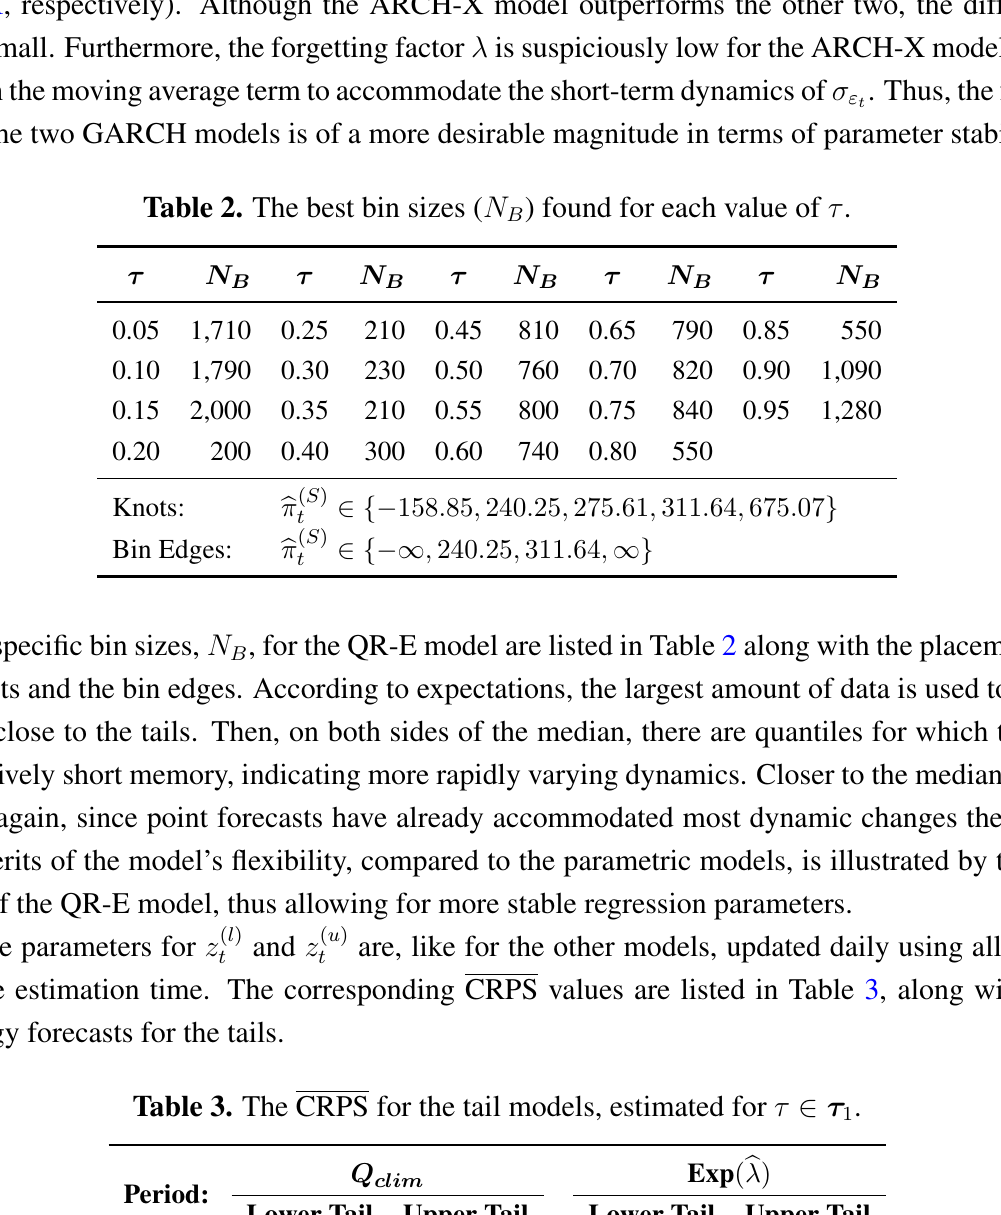
Table 2. The best bin sizes ( N